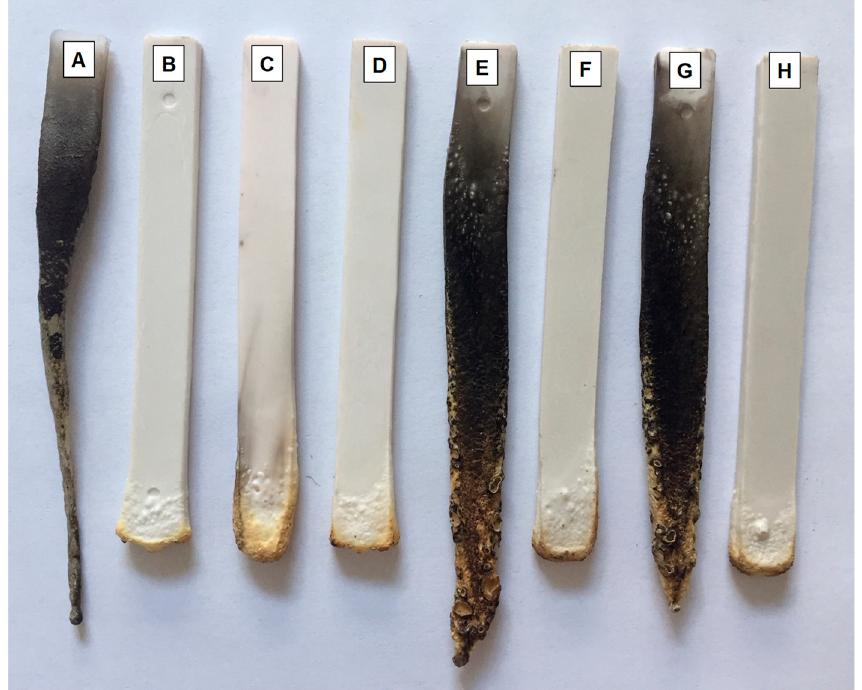
Figure 7. Digital pictures of specimens after UL94-V tests: ( A ) E-PE, ( B ) E-PE/185ATH, ( C ) E- PE/120ATH, ( D ) E-PE/120ATH/20TRZ, ( E ) E-PE/120ATH/15TRZ, ( F ) E-PE/120ATH/15TRZ/3clay, ( G ) E-PE/120ATH/10TRZ, and ( H ) E-PE/120ATH/10TRZ/5clay